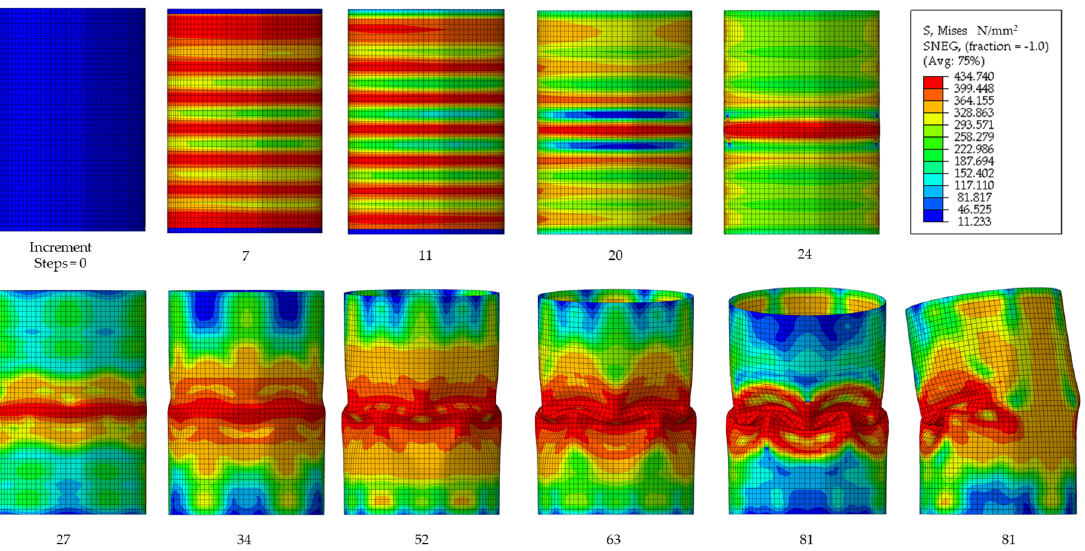
Figure 25. Shell (9 m at 36 mm) stress distributions and deformations at the compressive side of the cylindrical shell at 10 increment steps, and the view of tension side showing a flattening effect.